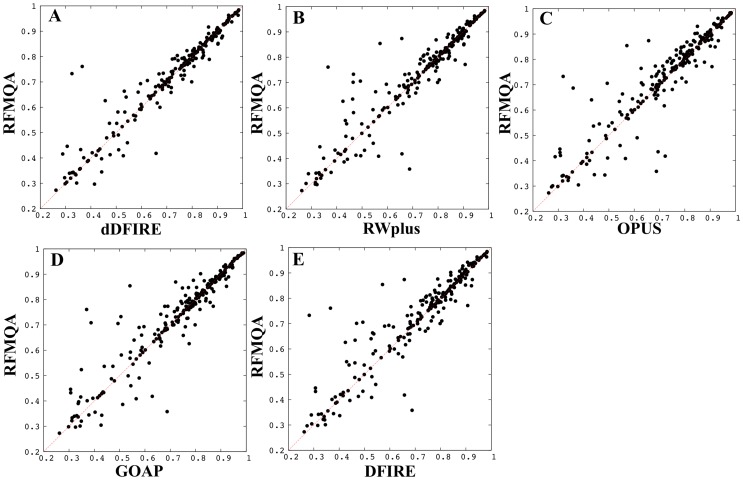
Pairwise comparisons.TMRF against TM-score of the model selected by individual statistical potential (TMQA) is shown; (A) dDFIRE versus RFMQA, (B) RWplus versus RFMQA, (C) OPUS versus RFMQA, (D) GOAP versus RFMQA, and (E) DFIRE versus RFMQA.